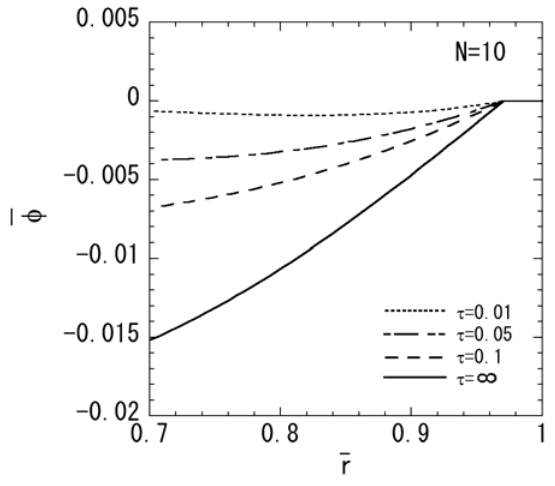
Figure 4. Variation of the electric potential (